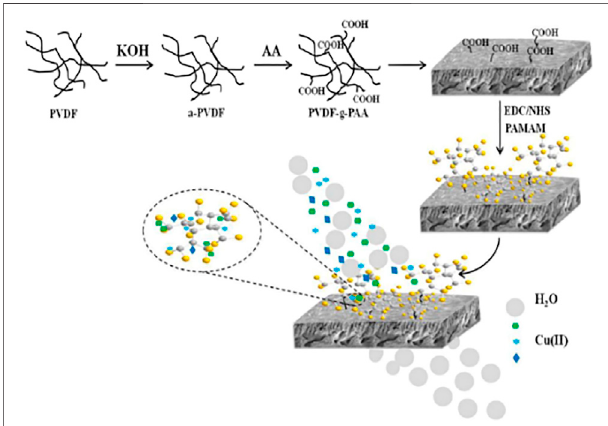
FIGURE 9 | The scheme of preparation of PVDF-g-PAA-PAMAM